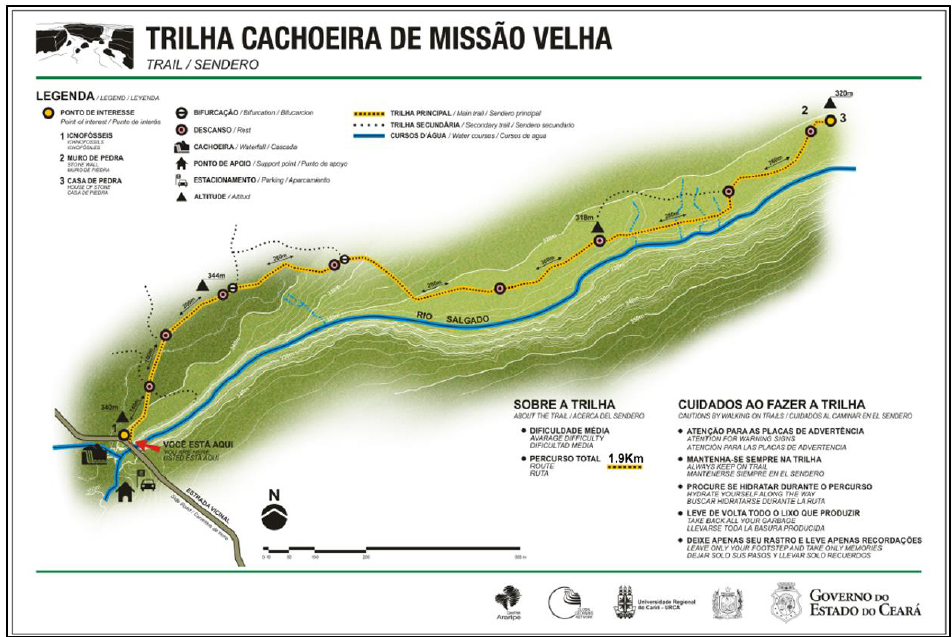
Figure 3. Missão Velha Waterfall Trail. Source: Trail Signaling Plan Araripe UGG [82]. Figure 3. Miss ã o Velha Waterfall Trail. Source: Trail Signaling Plan Araripe UGG